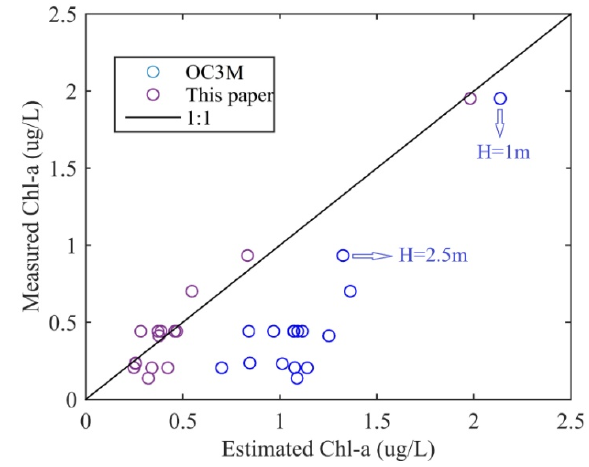
Figure 27. Comparison of the Chl-a retrieval results from the OC3M with the semi-empirical algorithm in this paper.